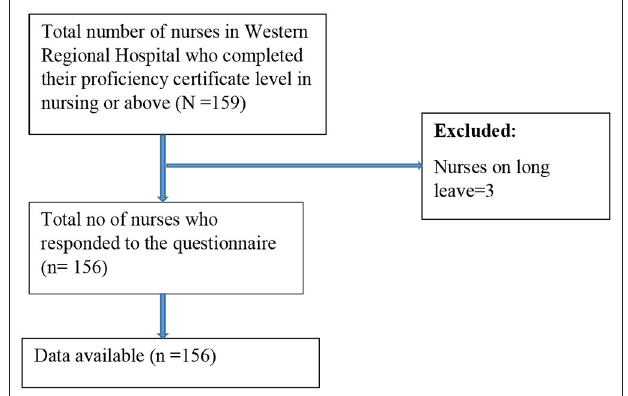
FIGURE 1 | Selection of participants for the